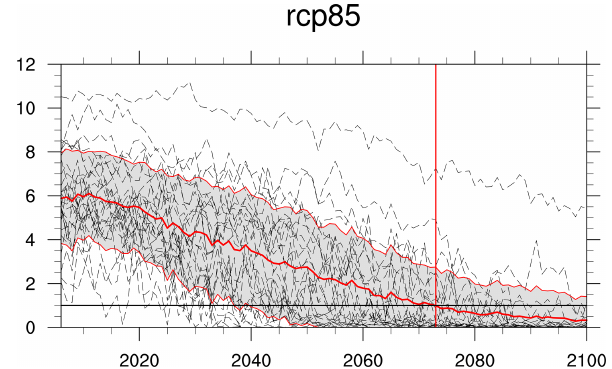
Figure 20. Time series of September Arctic sea ice extent for indi- vidual CMIP5 models (dashed gray lines), multi-model mean (thick red line) and multi-model standard deviation (area shaded between thin red lines) for scenario RCP8.5. The year of disappearance (sea ice extent below 1 million km 2 ) obtained from the CMIP5 multi- model mean is indicated by the vertical red line (similar to Collins et al., 2013, Fig. 12.31e). Produced with recipe_seaice.yml ; for de- tails, see Sect.